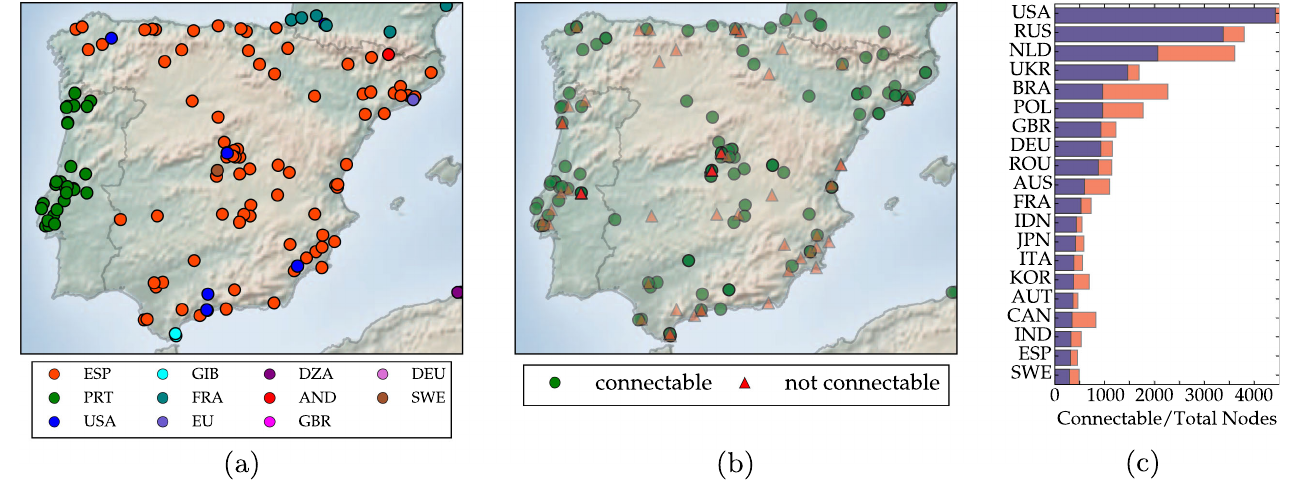
FIG. 4. Color-avoiding connectivity of the AS-level Internet. (a) Here, we show the routers of the AS-level Internet in the Iberian peninsula as a disjointly vulnerable network, with the colors determined by the country to which the router is registered. (b) The green nodes are members of this set, while the red are not. This means that these routers can take advantage of multiple paths to maintain security, as described in the main text. Panel (c) shows the number of CAC routers (nodes in L routers for the top 20 countries worldwide, in terms of total number of AS routers registered to that country in L have been truncated for visibility; the total number of AS routers is 17 690. We use a symmetrized version of the network of Ref. [34], which was generated using data from the CAIDA project [35] up to December